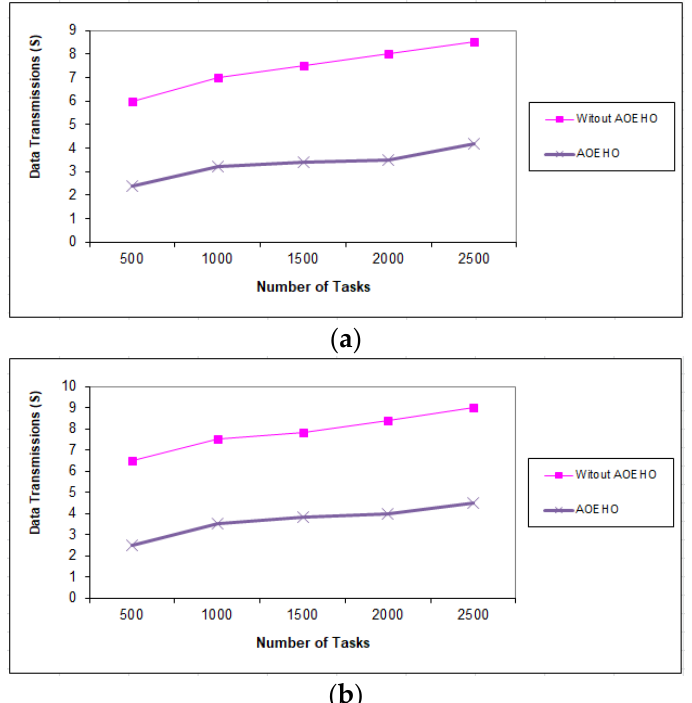
Figure 12. Data transmission between tasks = 2500 tasks. ( a ) Size of data replication = 64 MB. ( b ) Size of data replication = 320 MB.